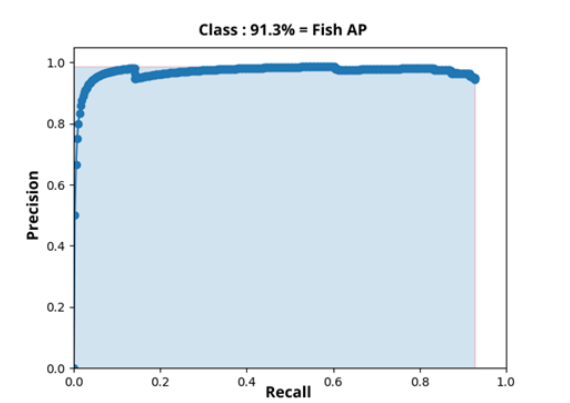
Figure 13 . Precision and Recall curve of the model. The markers indicate the points where recall and precision are obtained.